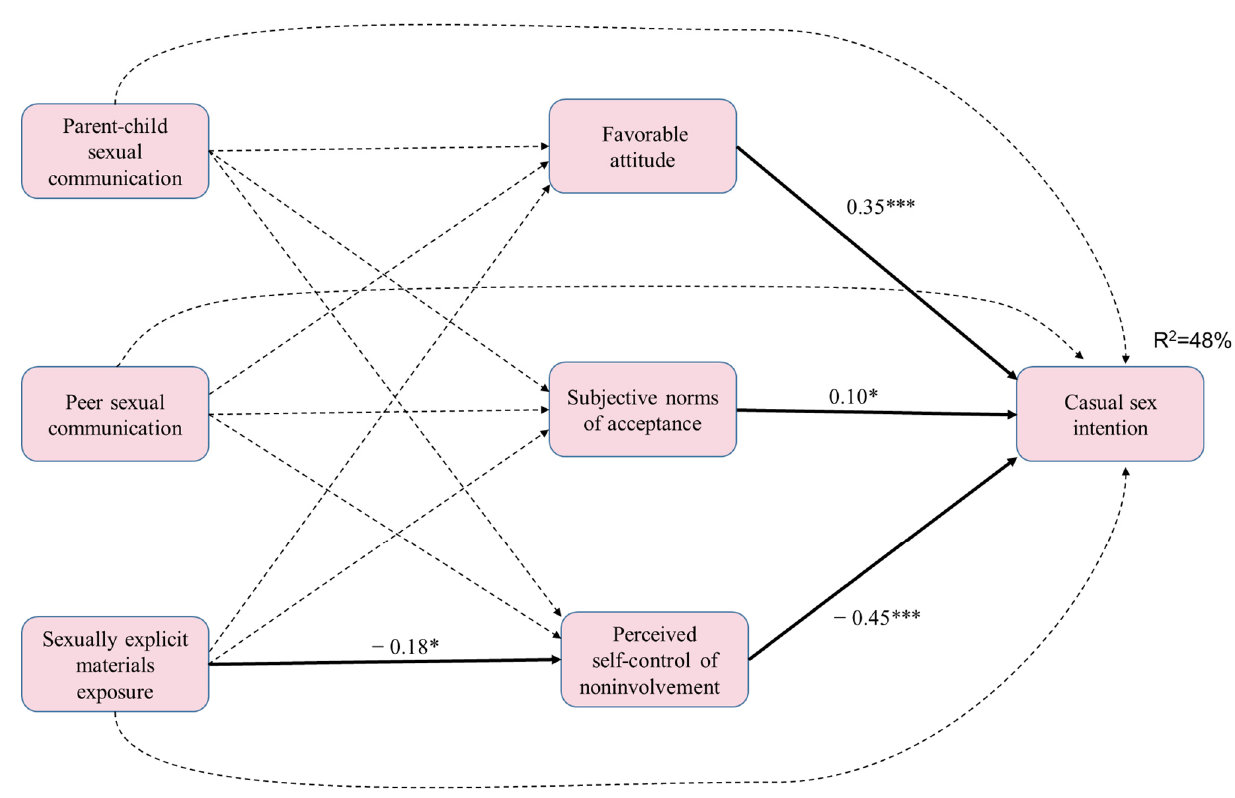
Figure 3. The standard coefficient of women. *** p < 0.001; ** p < 0.01; * p < 0.05. Solid lines denote significant paths and dotted lines denote non-significant paths. Table 5. Comparison of the paths between the models among men and